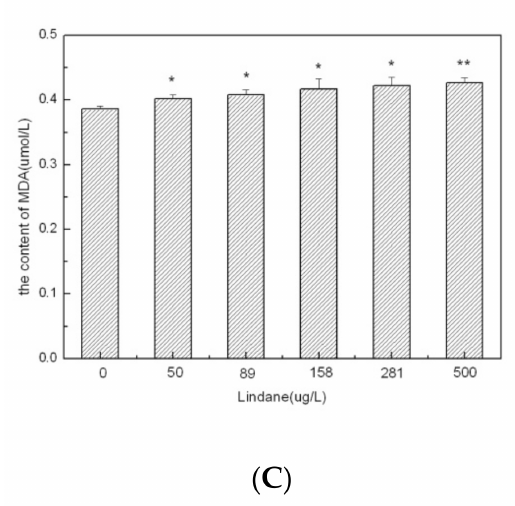
Figure 2. Cellular effects of Lindane on Microcystis aeruginosa (96 h): ( A ) protein content; ( B ) SOD activities; ( C ) MDA content. Each value is the mean ± S.D. * p < 0.05, ** p <